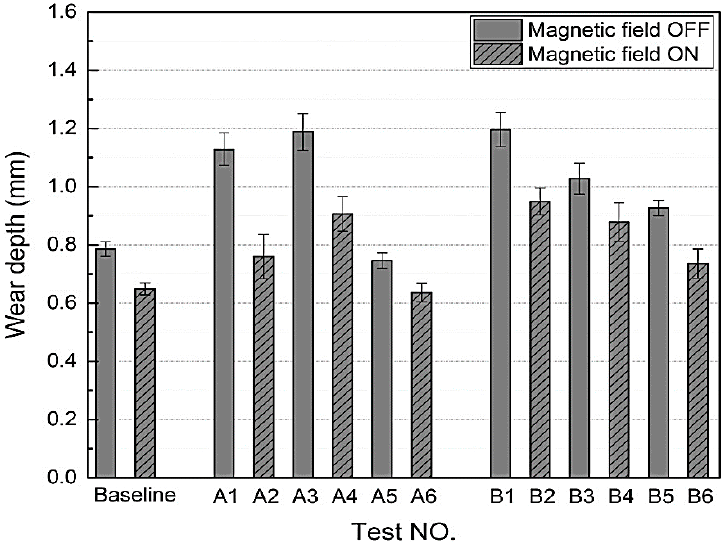
Figure 19. Wear depth obtained after all tests [34] (reprinted with permission from Elsevier TM ).